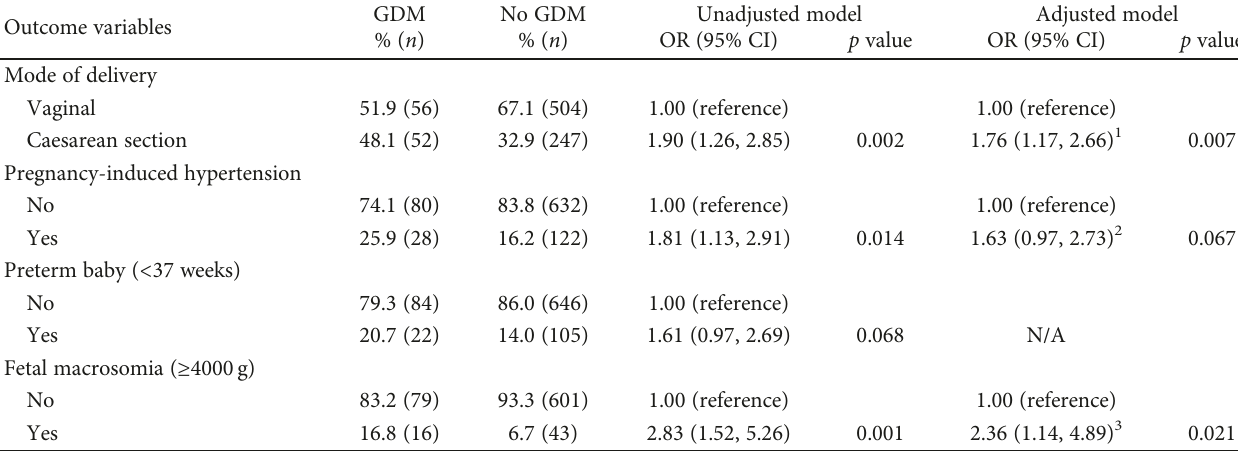
Table 3: Associations between gestational diabetes mellitus status and pregnancy-related, fetal, and neonatal complications. Outcome